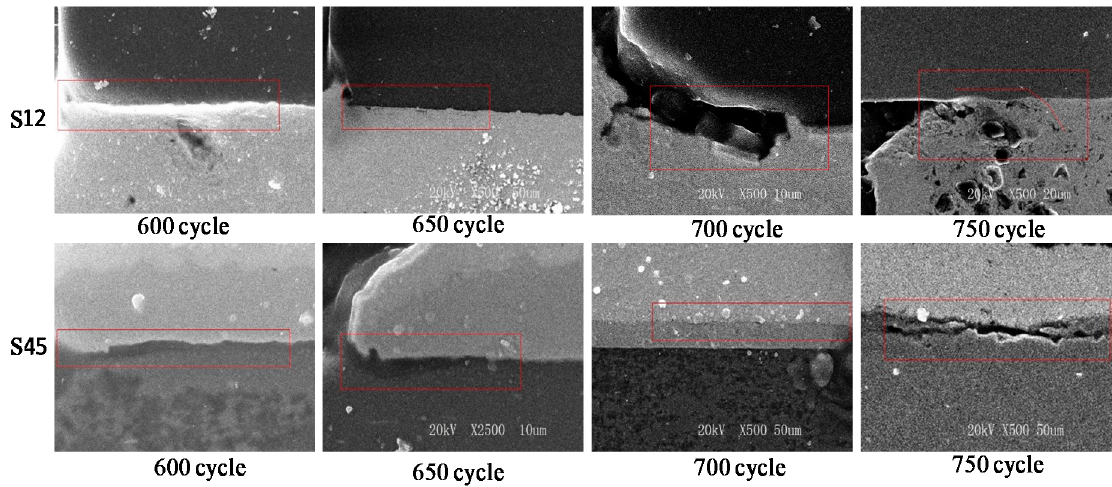
Figure 4. RI of chip Q2 vs. thermal cycles.